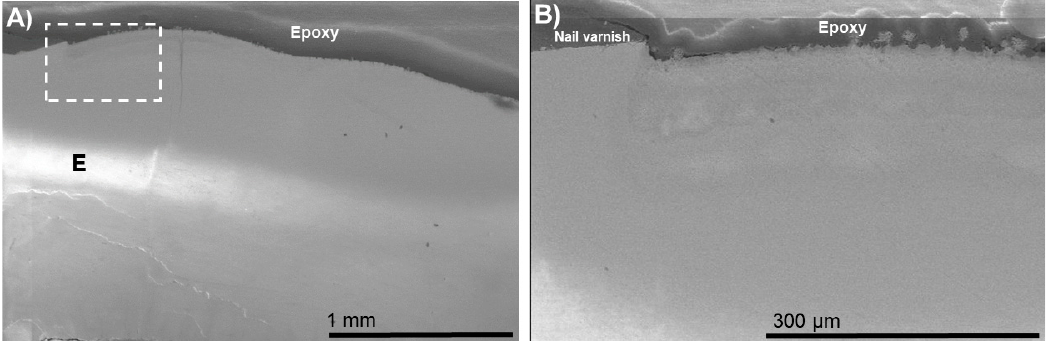
Figure 5. SEM images of the specimens in the bacteria-induced enamel demineralization followed by remineralization in PILP solution containing OPN as process-directing agent (BIED-REM OPN group). ( B ) High-magnification SEM image of ( A ) showing the area under the dotted outline rectangle. E: enamel.